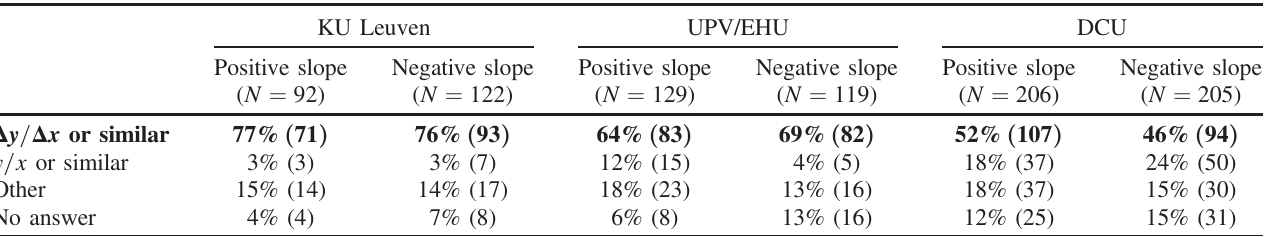
TABLE III. Categorization and prevalences of approaches to determining the slope of a context-free graph at a particular point. Correct responses are printed in